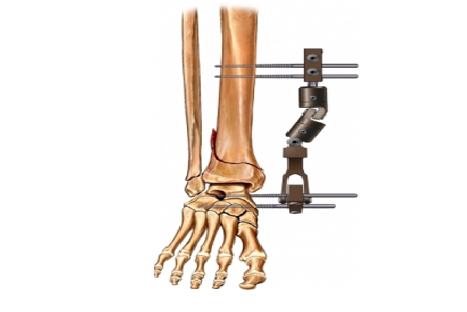
Figure 1 – External fixation of